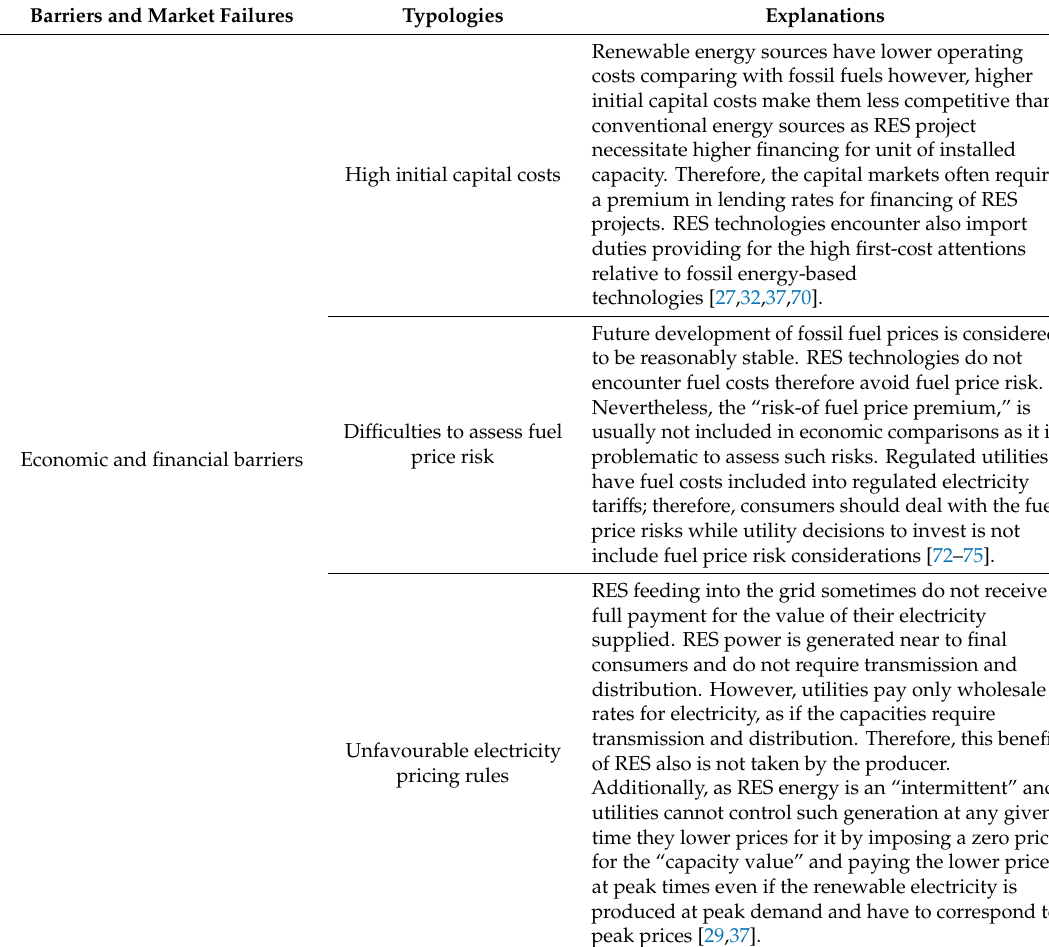
Table 3. Barriers of renewables penetration in